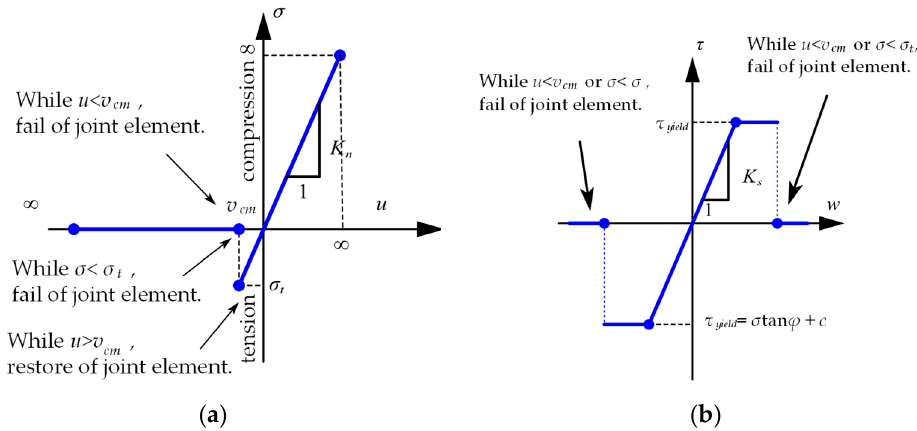
Figure 5. Schematic diagram of the joint element.